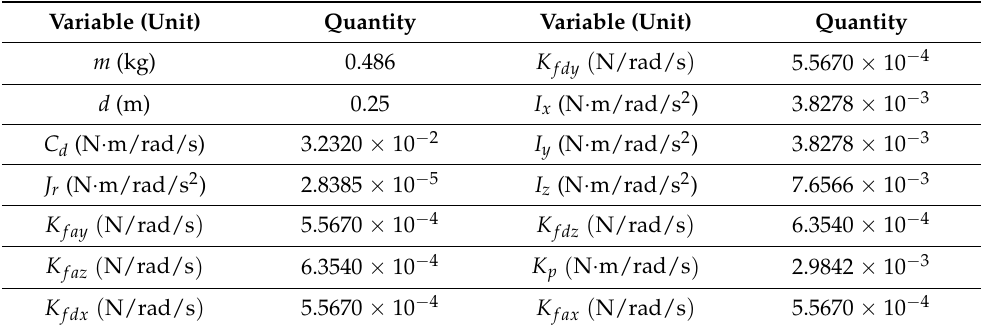
Table 2. Parameters of the quadrotor’s system